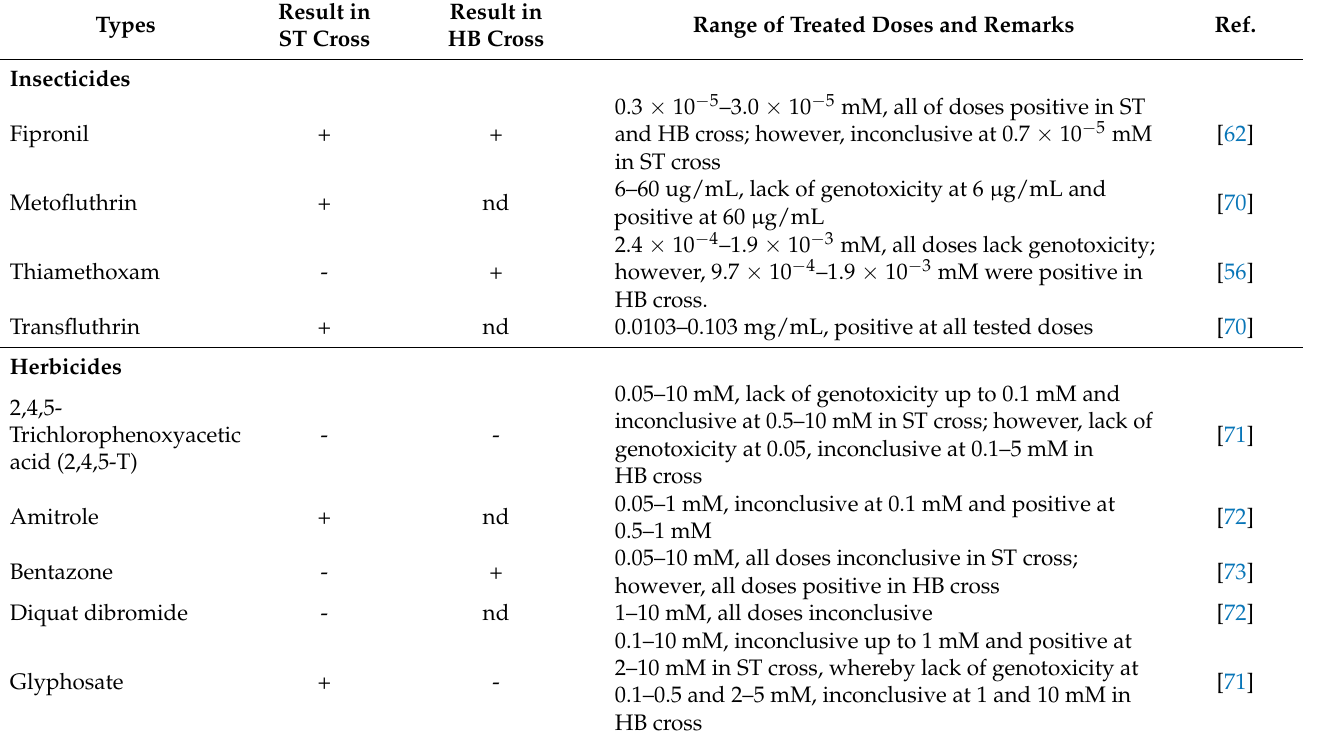
Table 3. Applications of SMART for testing insecticide and